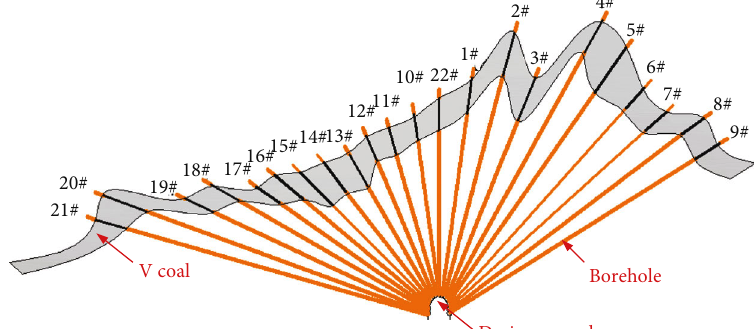
Figure 12: Drilling design of each group borehole in No.2164